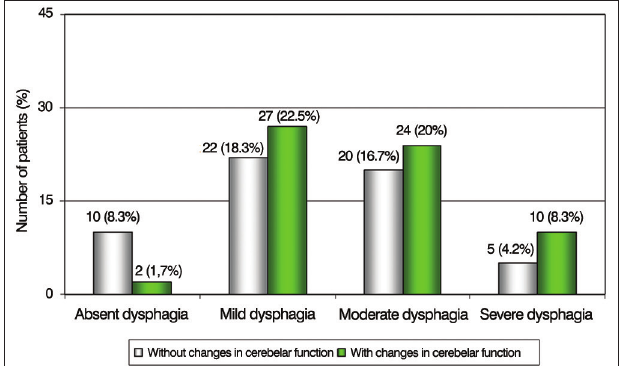
Figure 2. Patient distribution according to the severity of dysphagia and changes in cerebellar function in the Functional Disability Scale by Systems